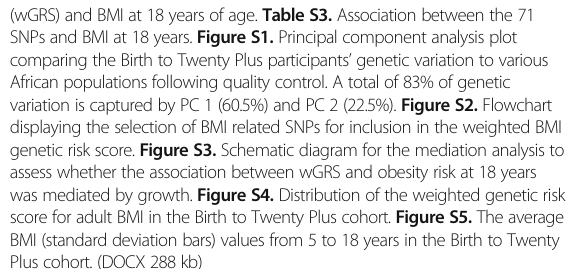
(wGRS) and BMI at 18 years of age. Table S3. Association between the 71 SNPs and BMI at 18 years. Figure S1. Principal component analysis plot comparing the Birth to Twenty Plus participants ’ genetic variation to various African populations following quality control. A total of 83% of genetic variation is captured by PC 1 (60.5%) and PC 2 (22.5%). Figure S2. Flowchart displaying the selection of BMI related SNPs for inclusion in the weighted BMI genetic risk score. Figure S3. Schematic diagram for the mediation analysis to assess whether the association between wGRS and obesity risk at 18 years was mediated by growth. Figure S4. Distribution of the weighted genetic risk score for adult BMI in the Birth to Twenty Plus cohort. Figure S5. The average BMI (standard deviation bars) values from 5 to 18 years in the Birth to Twenty Plus cohort. (DOCX 288